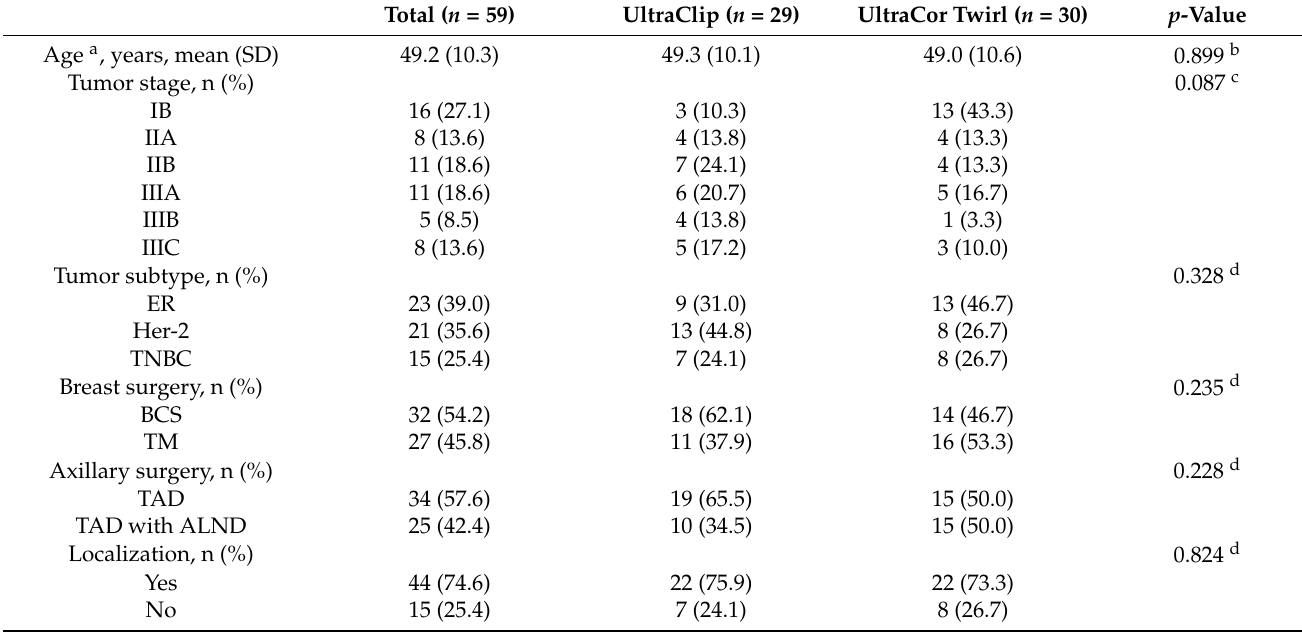
Table 1. Patient